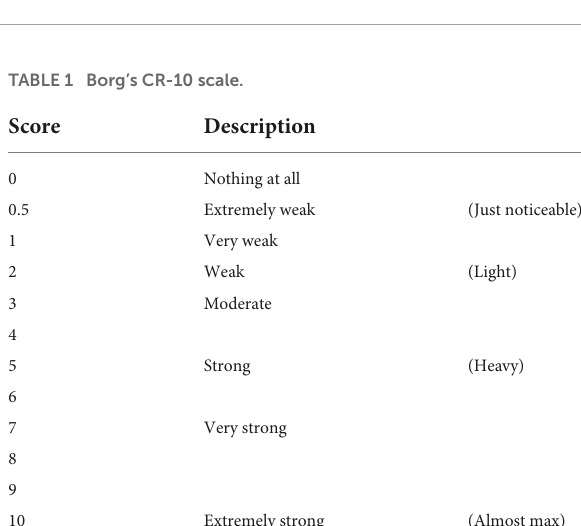
FIGURE1 Channel layout.